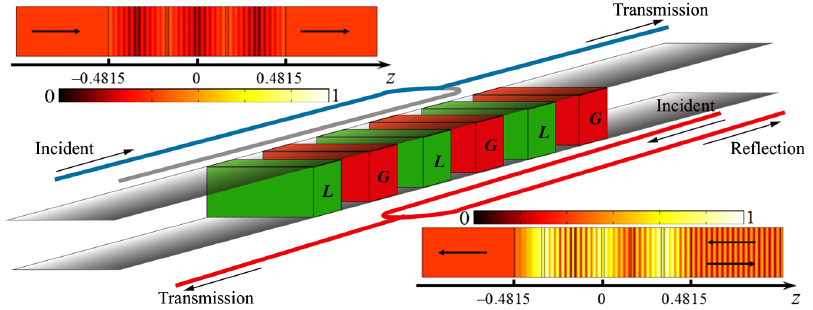
FIG. 1. Schematic of the acoustic PT -symmetric medium. The scattering domain is composed of 11 sections: three gain regions (red blocks), three loss regions (green blocks), and five passive regions in between. The length of the active region is 0.148 m, while the length of each passive region is 0.015 m. The transmission and reflection of acoustic waves incident from the left (blue curve) and right (red curve) are shown. This PT -symmetric medium is designed to be reflectionless for acoustic waves incident from the left. Insets: The normalized amplitude of the pressure field for the left (left inset) and right (right inset) incidences at the exceptional